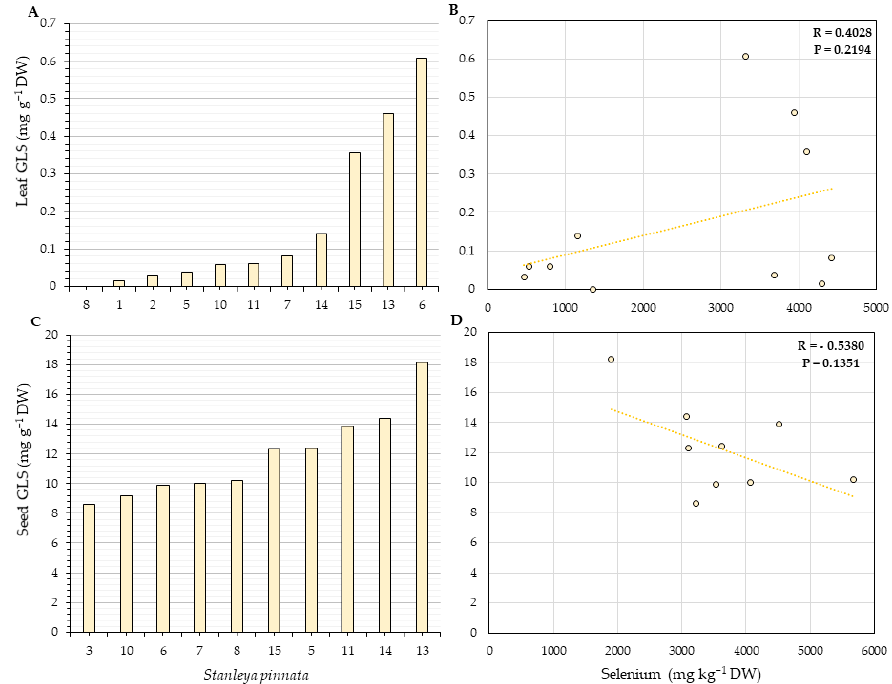
Figure 11. Total glucosinolates (GLSs) concentration in leaves ( A ) and seeds ( C ) and their correlation with leaf ( B ) and seed ( D ) Se concentration for S. pinnata plants growing at Pine Ridge (locations shown in Figure 3). The numbers on the horizontal axis ( A , C ) represent the collection numbers for individual plants at the locations indicated in Figure 3. The graphs show the correlation coefficient R and p -value for panels ( B , D ).